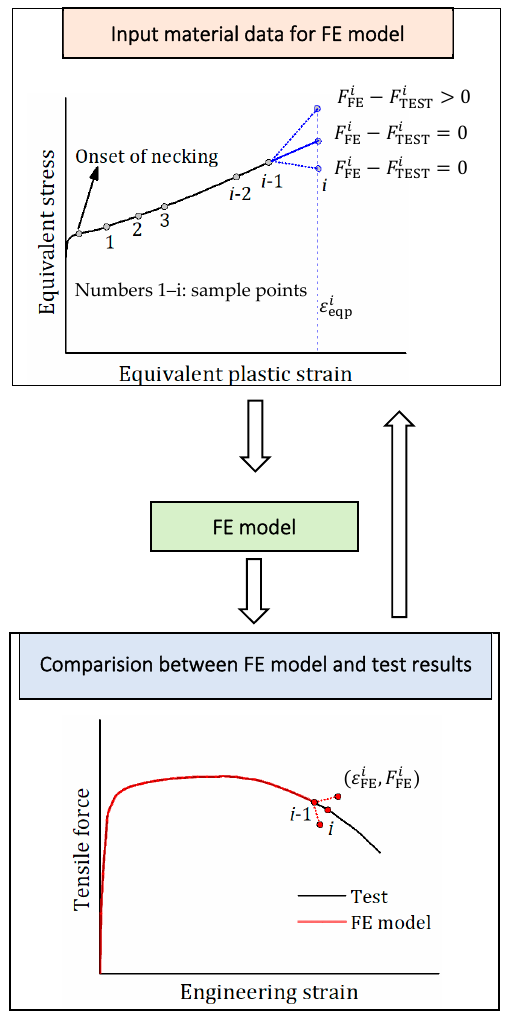
Figure 5. Diagrammatic sketch of the procedure for determining equivalent stress-plastic strain curves at 550–800 °C.